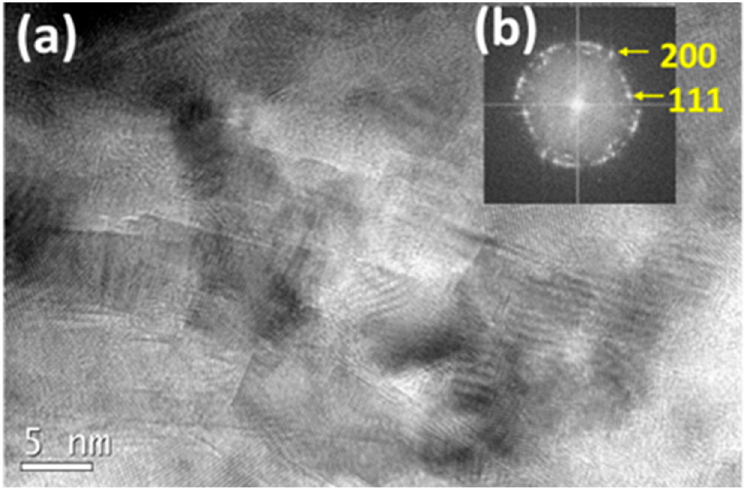
Figure 12. ( a ) TEM image of rocksalt-CoO nanoparticles and ( b ) corresponding fast Fourier transform (FFT) pattern.